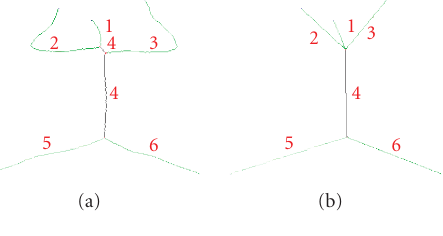
Figure 4: Skeleton relocation.